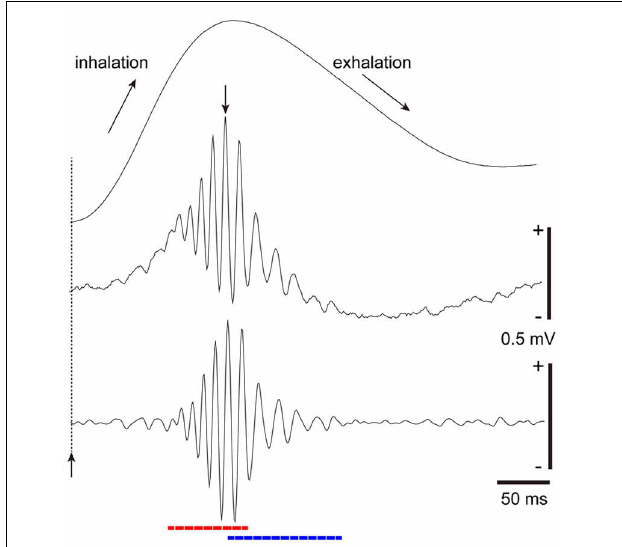
FIGURE 4 | Fast and slow gamma oscillations in the olfactory bulb. Middle trace: sniff rhythm-paced gamma oscillations recorded from the granule cell layer of the olfactory bulb of a freely behaving rat. The sniff-induced local field potentials (LFPs) were averaged ( n = 277 sniffs) in reference to the peak (a downward arrow) of gamma oscillations that occur near the phase of transition from inhalation to exhalation. Bottom trace: the local field potential shown in the middle trace was band-path filtered between 30 and 140Hz. The sniff-paced gamma oscillations consist of early-onset fast gamma oscillation (red dashed line) and later-onset slow gamma oscillation (blue dashed line). Uppermost trace: respiration monitor via a thermocouple implanted in the nasal cavity. Upward reflection indicates inhalation. Sniff-onset is indicated by a vertical broken line with an upward